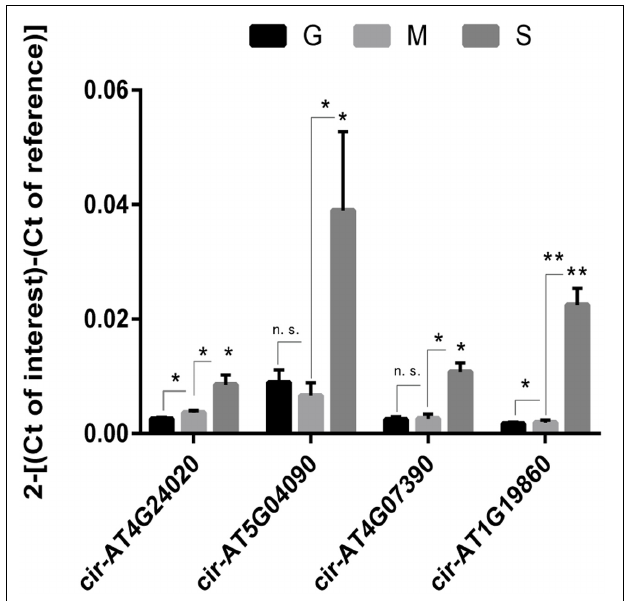
FIGURE 2 | Validation of the expression pattern of four highly expressed circRNAs by real-time PCR. Real-time PCR was used to verify the expression of four highly expressed circRNAs during leaf growth, maturation and senescence. Three replicates were made. The expression of actin gene was used as the internal reference. Asterisk on S bars reflect significant changes versus G ( n = 3). Error bars represent standard error of the mean. n.s., not significant. ∗ P < 0.05; ∗∗ P <